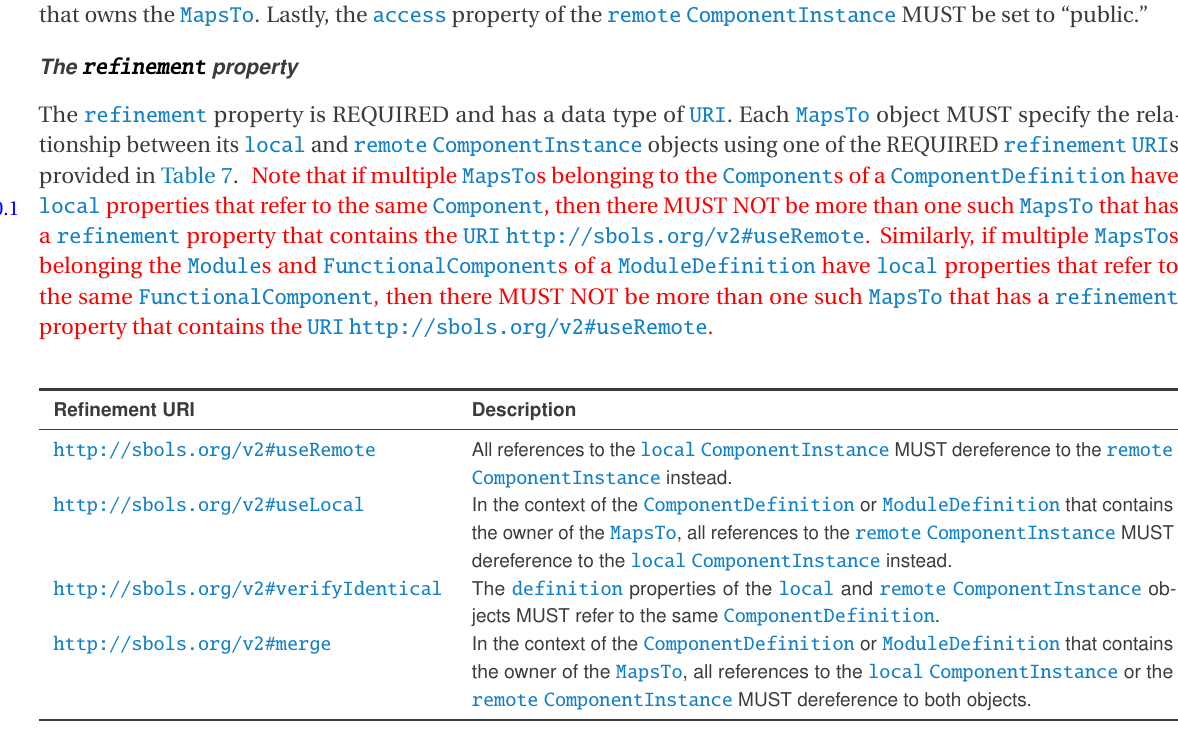
Table 7: REQUIRED URI s for the refinement